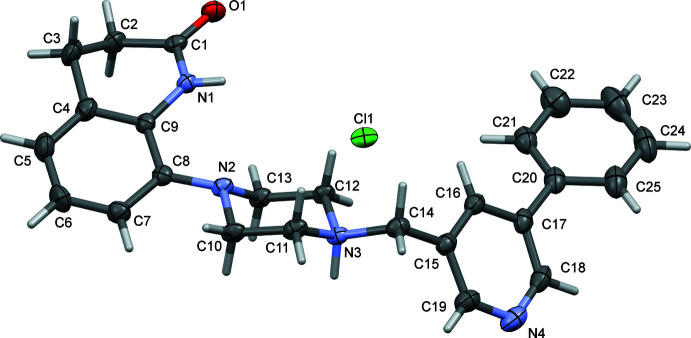
A view of the mol­ecular structure of I·HCl, with atom labelling. The displacement ellipsoids are drawn at the 50% probability level.